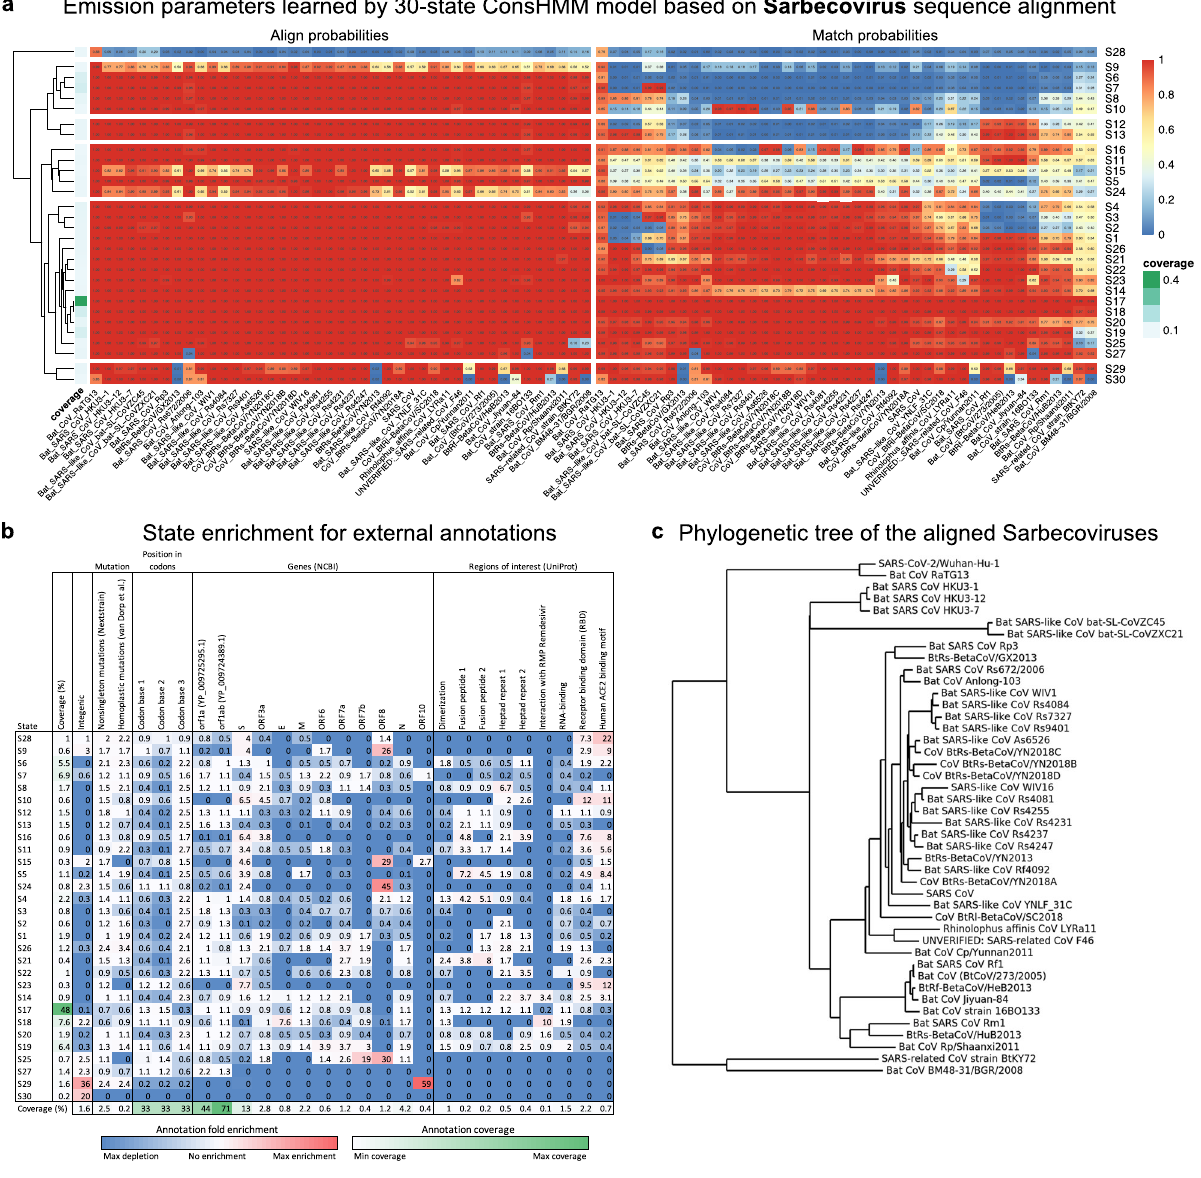
Fig. 2 ConsHMM conservation states learned from the Sarbecovirus alignment. a State emission parameters learned by ConsHMM. The left half of the heatmap shows for each state the probability of each CoV strain having a base aligning to a base in the reference, which is SARS-CoV-2. The right half shows for each state the probability of each CoV strain having a base aligning to and matching (having the same nucleotide) a base in the reference. In both halves, each row in the heatmap corresponds to a ConsHMM conservation state with its number on the right side of the heatmap. Rows are ordered based on hierarchical clustering and optimal leaf ordering 34 . In both halves, each column corresponds to SARS-CoV or one of the 42 CoV that infect bats. Columns are ordered based on each strain ’ s phylogenetic divergence from SARS-CoV-2 according to the phylogenetic tree shown in c , with closer strains on the left. The column on the left shows the genome-wide coverage of each state colored according to a legend labeled “ coverage ” on the right. b State enrichment for external annotations of mutations, codons, genes, and regions of interest. The fi rst column of the heatmap corresponds to each state ’ s genome coverage, and the remaining columns correspond to fold enrichments of conservation states for external annotations of intergenic regions, mutations, position within codons, NCBI gene annotations 31 , and UniProt regions of interest 19 . Each row, except the last row, corresponds to a conservation state, ordered based on the ordering shown in a . The last row shows the genome coverage of each external annotation. Each cell corresponding to an enrichment value is colored based on its value with blue as 0 (annotation not overlapping the state), white as 1 to denote no enrichment (fold enrichment of 1), and red as the global maximum enrichment value. Each cell corresponding to a genome coverage percentage value is colored based on its value with white as the minimum and green as the maximum. All annotations were accessed through the UCSC Genome Browser 1 except for nonsingleton mutations from Nextstrain 27 and homoplastic mutations from a prior study 18 . c Phylogenetic tree of the Sarbecoviruses included in the alignment. Each leaf corresponds to a Sarbecovirus strain included in the 44-way Sarbecovirus alignment. This tree was obtained from the UCSC Genome Browser 1 and plotted using Biopython 35 . SARS-CoV-2/Wuhan-Hu-1, the reference genome of the alignment, is at the